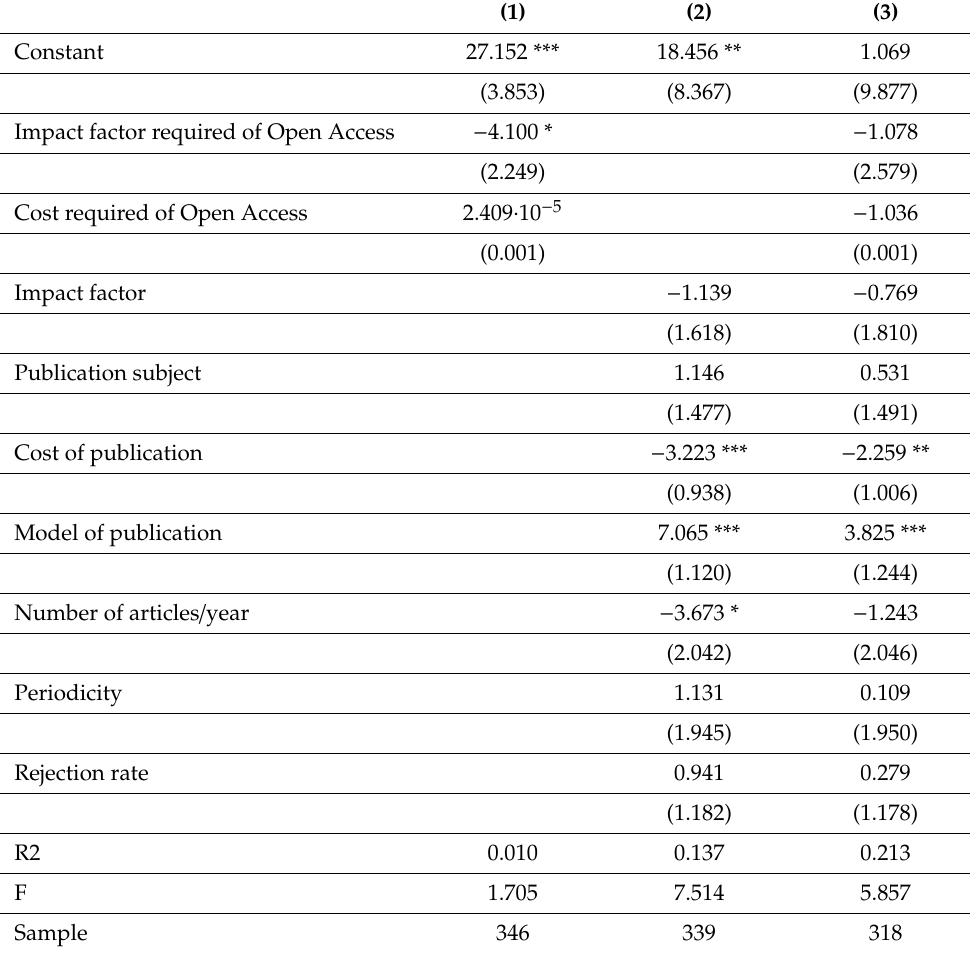
Table A1. Determining factors of the percentage of Open Access publications. Regression by Ordinary Least Squared